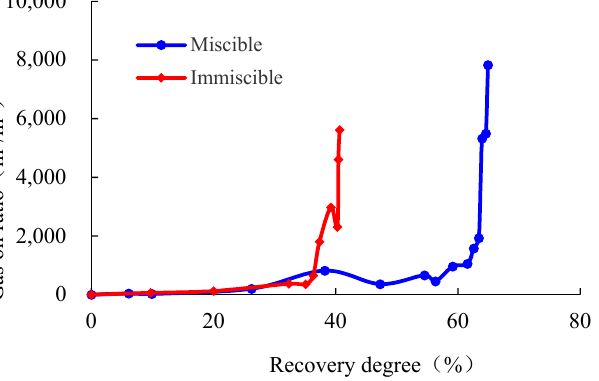
Figure 4. The relationship between recovery degree and gas–oil ratio (0.434 mD core).